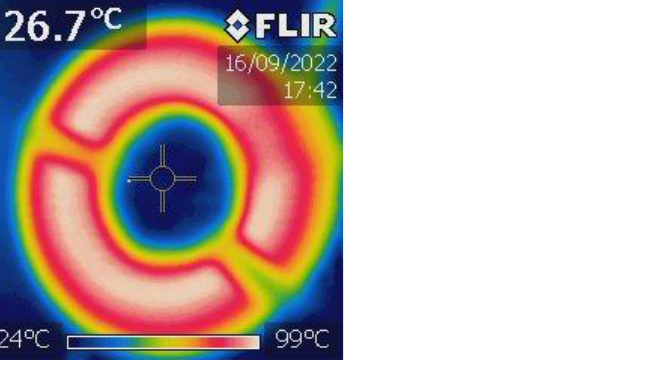
Figure 15. Temperature distribution on the surface of the primary winding of the transformer at R L = 4.7 Ω and frequency of the excitation signal equal to 100 kHz . R L = 4.7 Ω and frequency of the excitation signal equal to 100